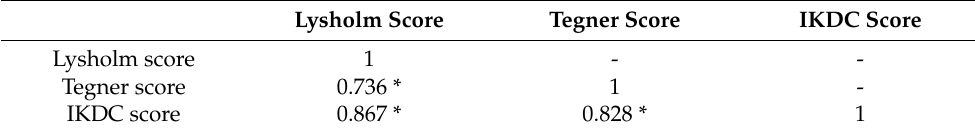
Table 2. Correlation matrix of Spearman rank correlation coefficients.